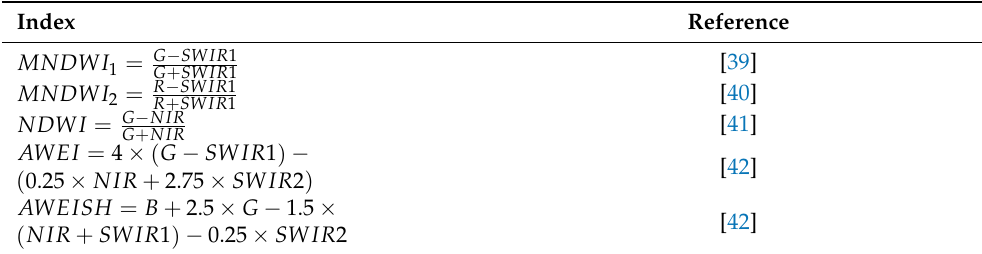
Table 2. Indexes used to detect water bodies in multispectral